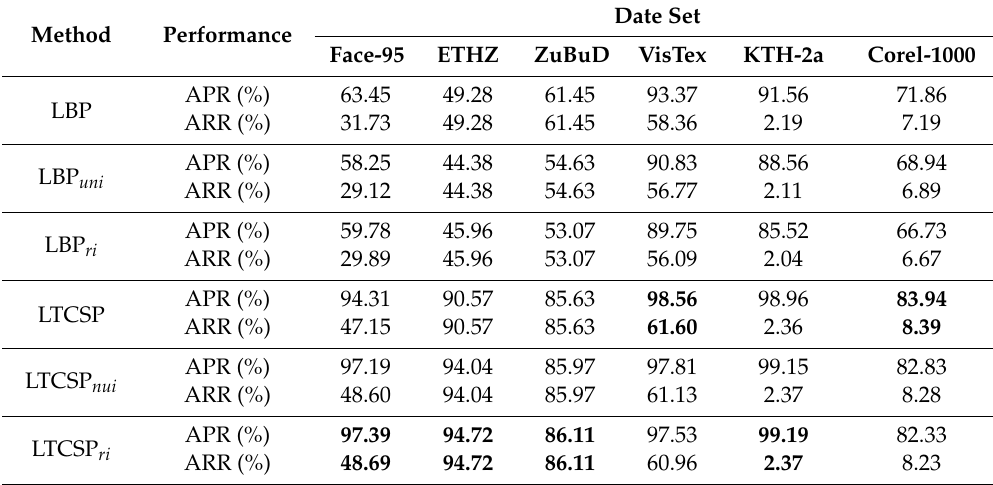
Table 4. The evaluations the APR and ARR rates resulting from the proposed methods and the LBP-based methods on six